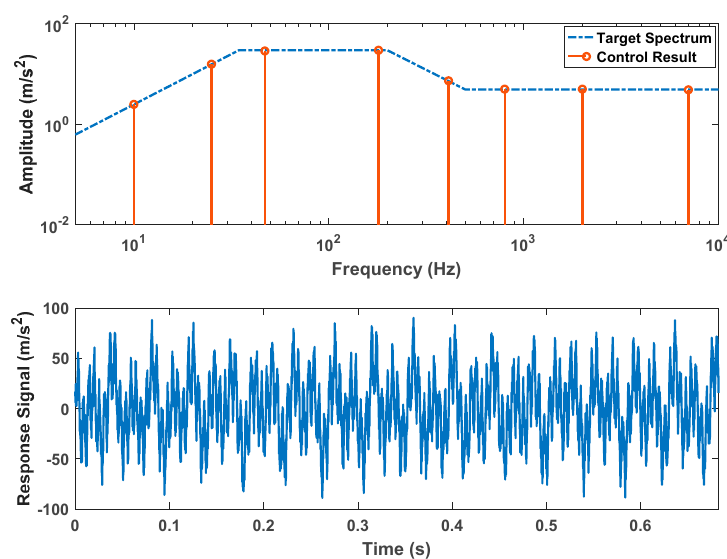
Figure 6. The spectrum and response signal curve of dwell experiment. Table 1. The control results of eight components in dwell experiment.